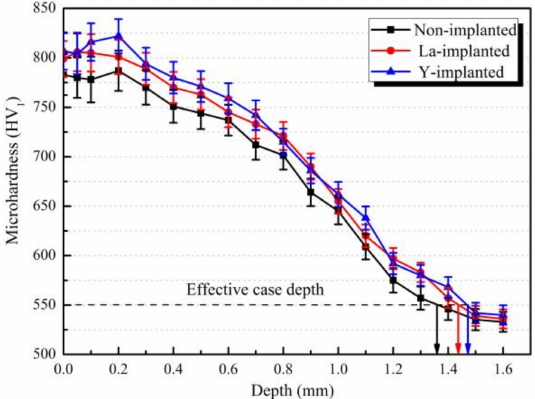
Figure 12. The microhardness distribution of the carburized layer along the depth